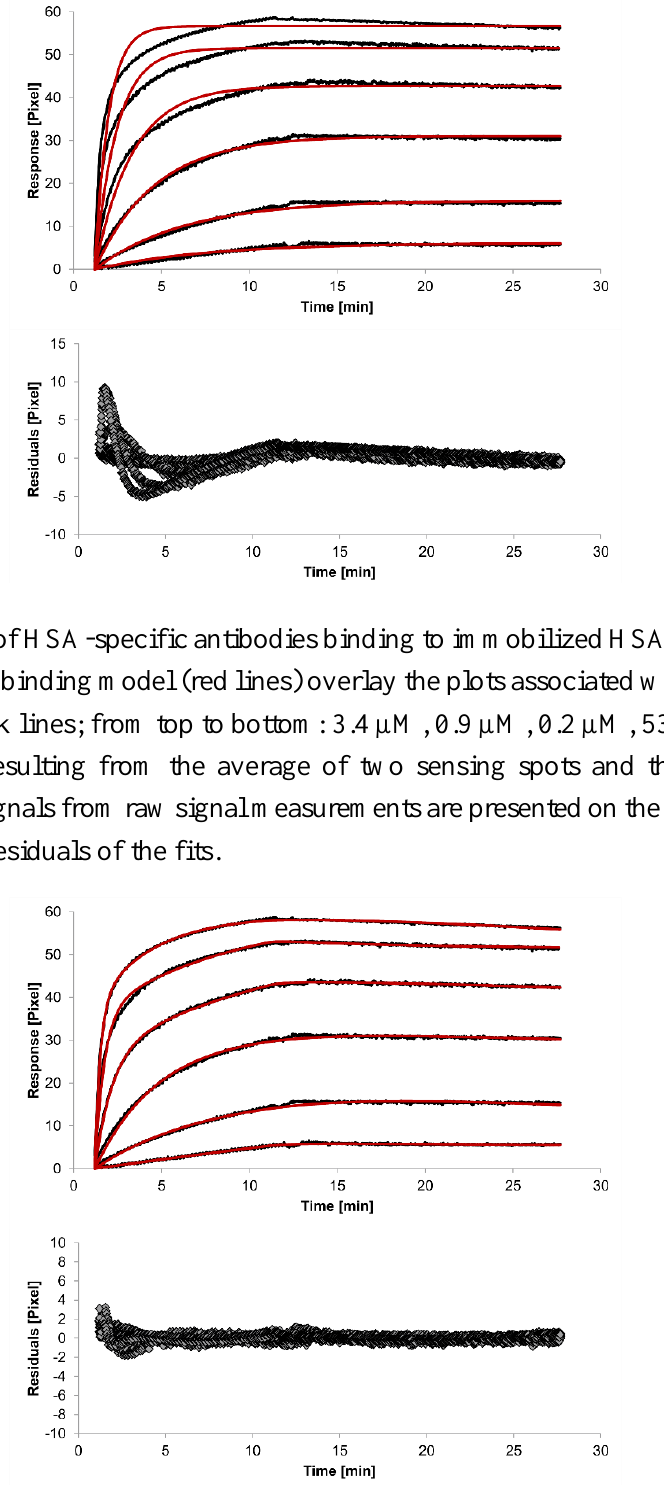
Figure 3. Kinetics of HSA-specific antibodies binding to immobilized HSA. Plots generated by applying the heterogeneous analyte model (red lines) overlay the plots associated with each antibody concentration (black lines; from top to bottom: 3.4 µM, 0.9 µM, 0.2 µM, 53.9 nM, 13.5 nM, 3.4 nM). Values resulting from the average of two sensing spots and the subtraction of reference surface signals from raw signal measurements are presented on the graph. The graph below depicts the residuals of the